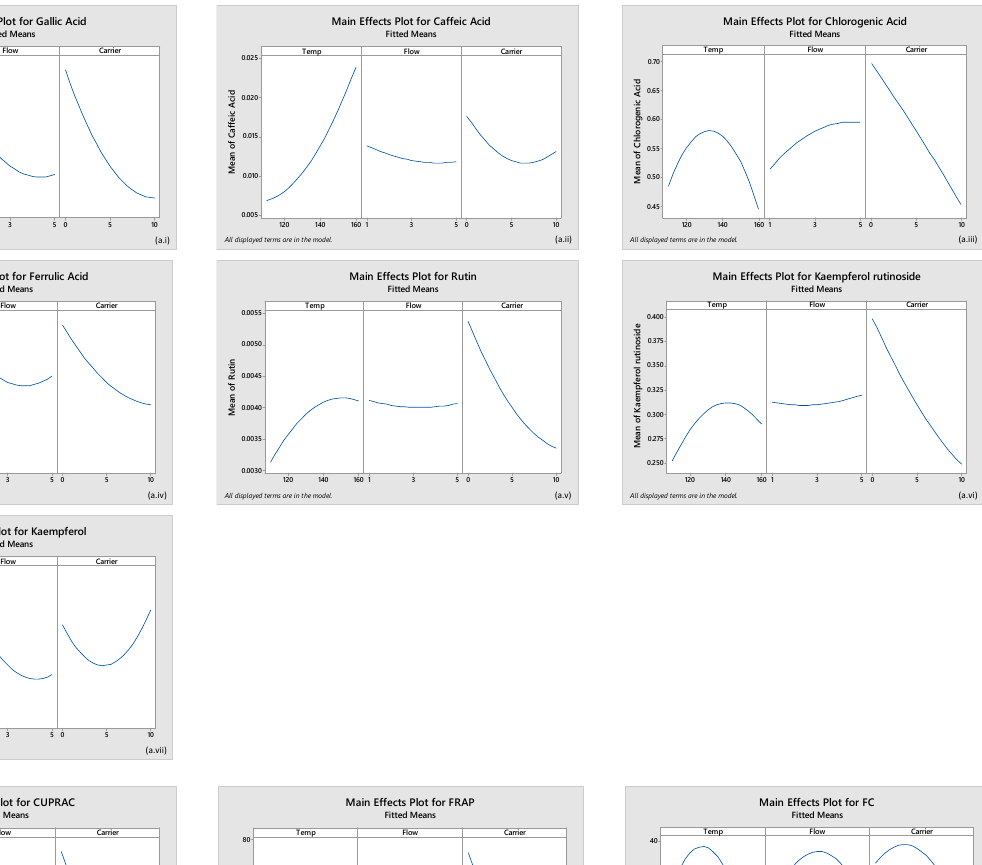
Figure A1 . LC-MS profile of individual polyphenol compounds of spray-dried tamarillo powder. The run is divided to different segments for different ions.